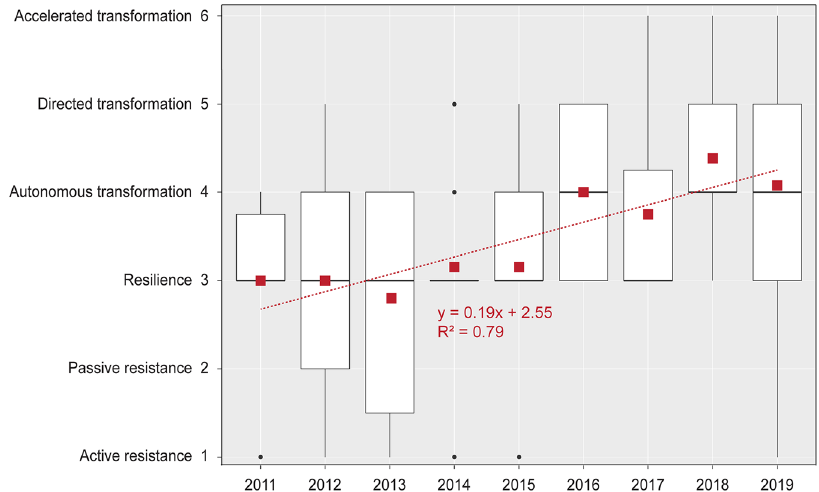
Fig. 3 Boxplot showing the distribution of R – R – T scores of CAF projects funded between 2011 and 2019. The center lines correspond to the median, the lower and upper hinges to the fi rst and third quartiles, and the upper and lower whiskers to the maximum and minimum values (no further than 1.5x interquartile range). Outliers are shown with black circles, and yearly mean scores with red squares. A best- fi t linear trendline with its equation and R- squared value is shown in